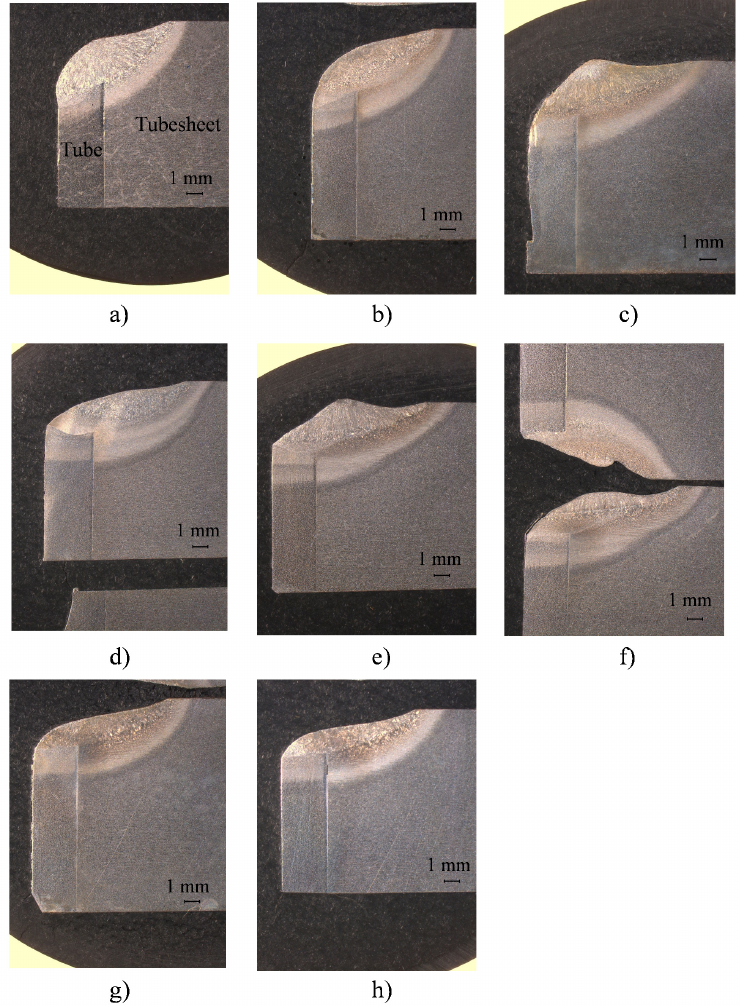
Figure 14. Macrographs of specimens at position 0 ◦ cut. Deviations in specimens of mockup 1: ( a ) +1 mm; In all macrographs, tube is on the ( left ) side and tubesheet on the ( right )